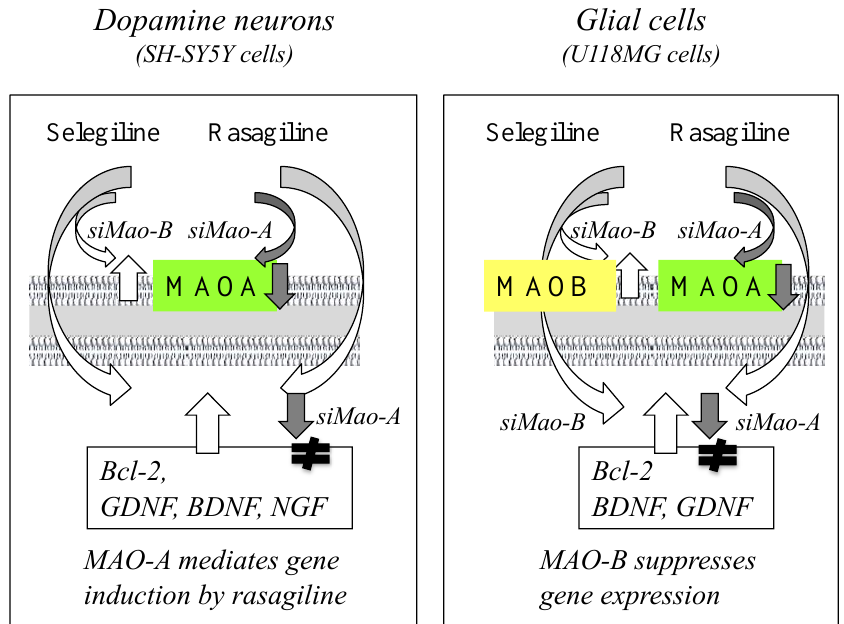
Figure 4. MAO-A and MAO-B are associated with gene induction by rasagiline and selegiline. Knockdown of MAO-A with siRNA downregulated gene expression by rasagiline in neuroblastoma SH-SY5Y cells, whereas MAO-B knockdown upregulated gene induction by selegiline in glioblastoma U118MG cells.